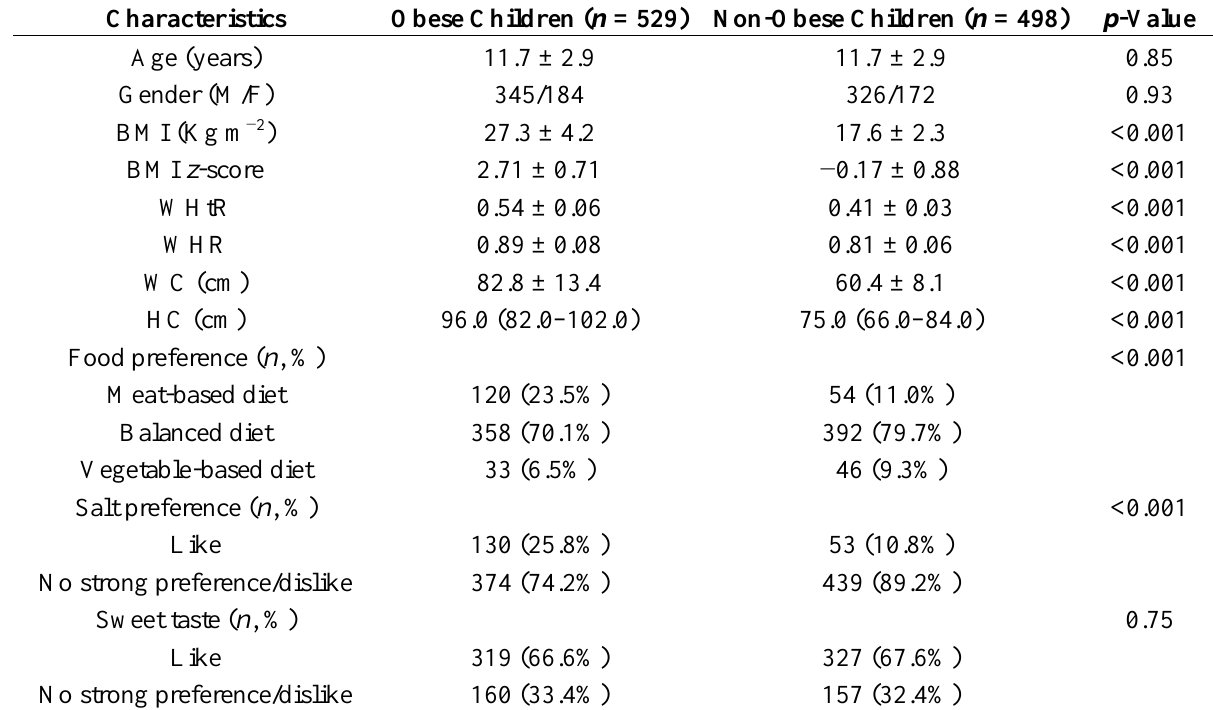
Table 2. Basic characteristics of the study